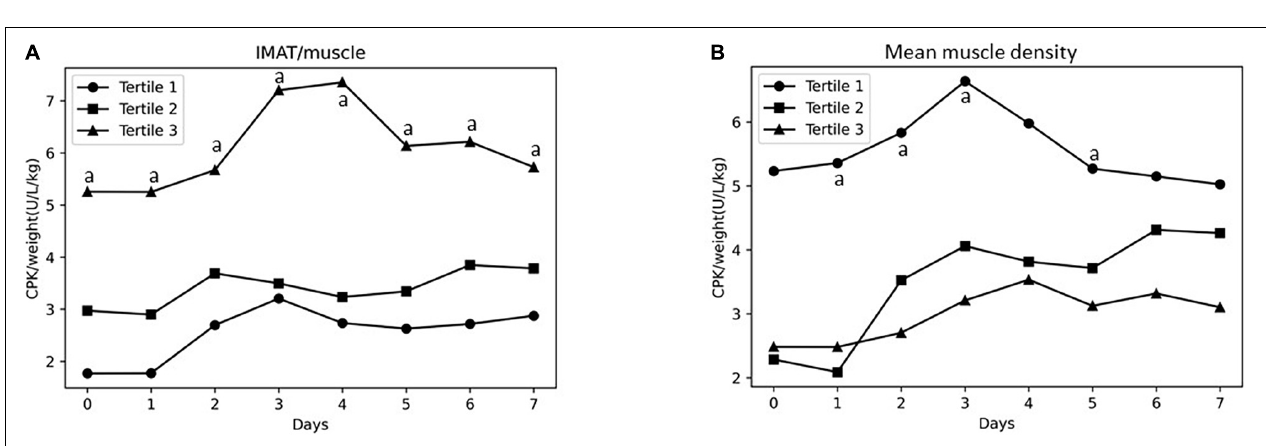
FIGURE 1 | Kaplan–Meier survival curves for all-cause mortality according to IMAT/muscle tertiles (A) and mean muscle density tertiles (B) . IMAT, intermuscular adipose tissue.